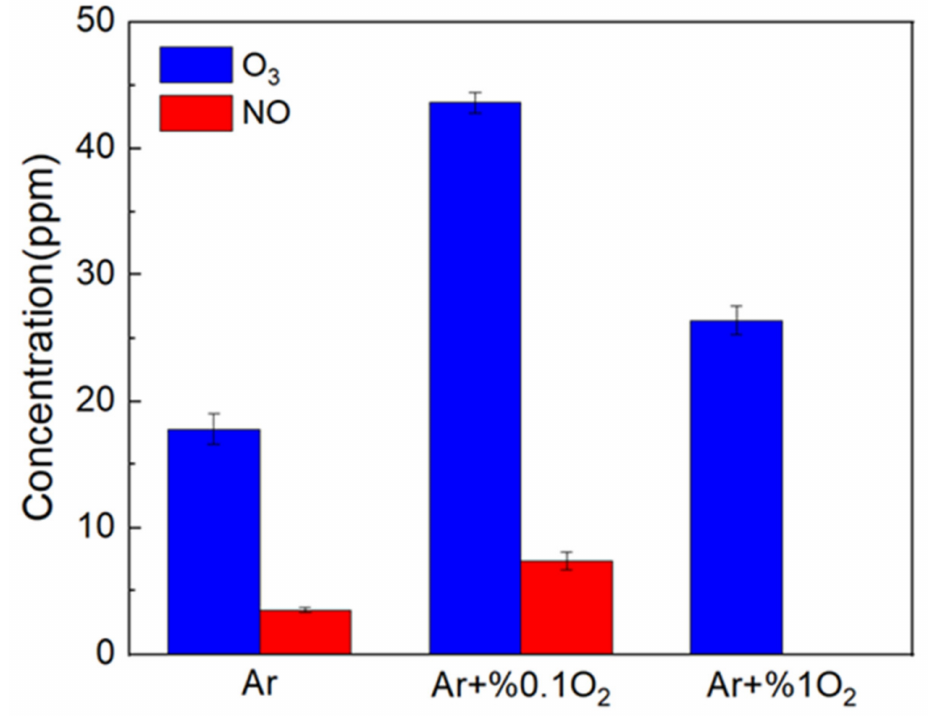
Figure 5. Concentration of O 3 and NO for the LTP jet array with the working gas of argon, argon + 0.1% O 2 , argon + 1% O 2